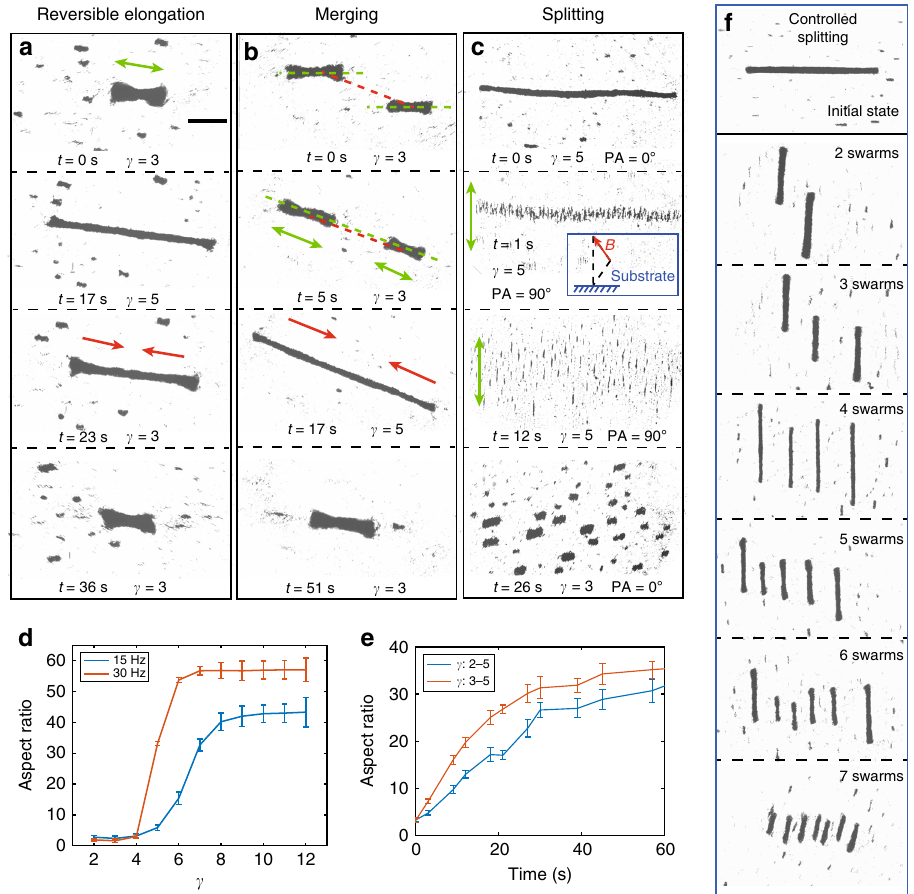
Fig. 3 Pattern recon fi guration of the microswarm. a The demonstration of the reversible elongation of an RPNS (Supplementary Movie 3). The green arrow shows the direction of elongation, and the red arrows show the direction of contraction. b The merging process of the two self-governed RPNSs (Supplementary Movie 4). The long axis of the RPNSs are labelled by green dashed lines, and the linking between the centres of the swarms are indicated by the red dashed line. The directions of elongation and contraction are labelled by green and red arrows, respectively. c The splitting process of an RPNS (Supplementary Movie 5). PA represents the pitch angle of the applied magnetic fi eld. d The change in the aspect ratio with the amplitude ratio γ . e The relationship between the aspect ratio of an RPNS and time. The applied oscillation frequency is 30 Hz. The blue curve indicates the results when the amplitude ratio increases from 2 to 5; while the red curve indicates the results when the amplitude ratio increases from 3 to 5. In d and e each data point represents the average of 3 experiments. The error bar indicates the standard deviation (s.d.). The scale bar is 600 μ m. f Controlled splitting of